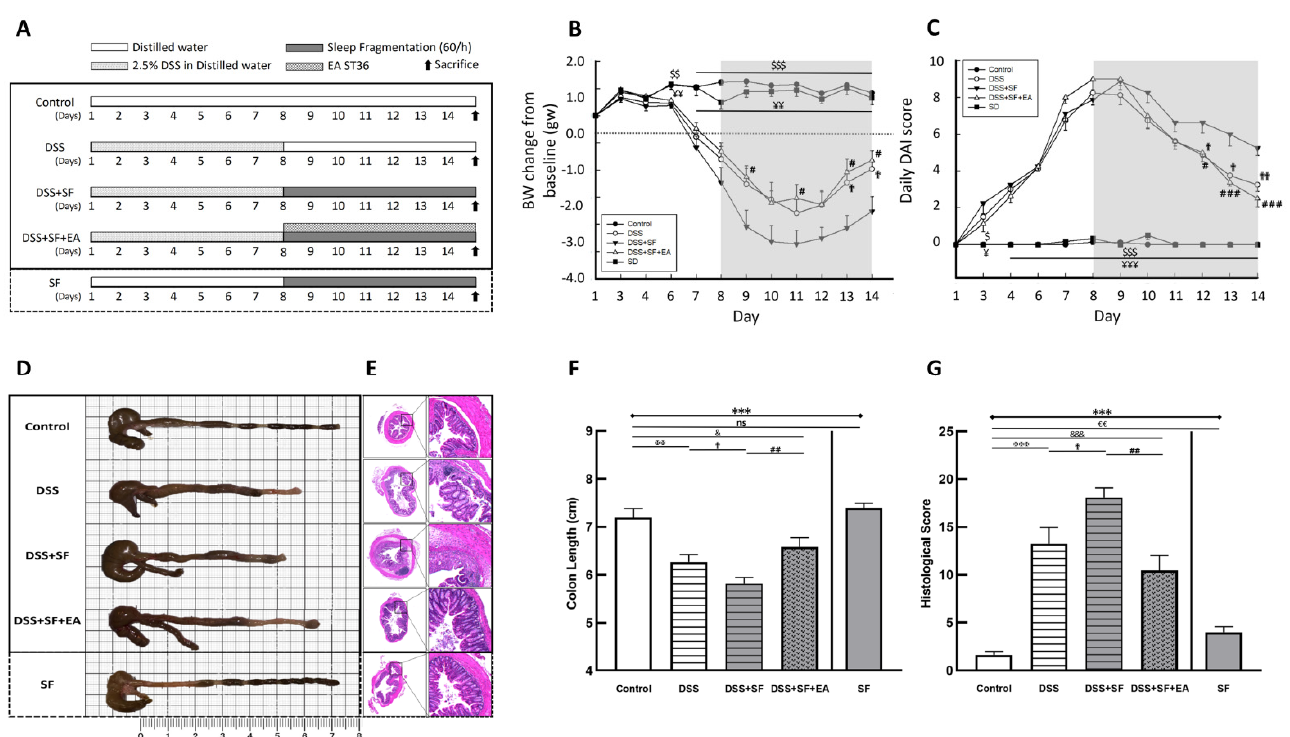
Figure 1. Electroacupuncture ameliorates dextran sulfate sodium (DSS)-induced colitis in sleep- fragmented C57BL/6 mice. ( A ) Experimental protocol of 2.5% DSS colitis, sleep fragmentation (SF) and electroacupuncture (EA) ST36 treatment course; ( B ) mice body weight loss after management of DSS or sleep fragmentation in five groups (statistics of differences between each group and DSS + SF group by Mann–Whitney U test); ( C ) daily DAI score in five groups (statistics of differences between each group and DSS + SF group by Mann–Whitney U test); ( D ) intestine photograph of colorectum length in each group; ( E ) representative H&E-stained colorectum sections (left: 40×, right: 200× magnification) in each group; ( F ) statistics of colon length in five groups by Kruskal–Wallis test; differences between each group by Mann–Whitney U test; ( G ) statistics of histological score in five groups by Kruskal–Wallis test; differences between each group by Mann–Whitney U test. * Stands for a result of five groups comparison (represented by bold line segments with endpoints). ✠ , $, ✟ , #, ¥, & and € represent the results of control group versus DSS group, control group versus DSS + SF group, DSS group versus DSS + SF group, DSS + SF group versus DSS + SF + EA group, DSS + SF group versus SF group, control group versus DSS + SF + EA group, and control group versus SF group, respectively (represented as a thin line without endpoints). $, ✟ , #, ¥, &, €, p < 0.05; ✠✠ , $$, ✟✟ , ##, ¥¥, €€, p < 0.01; ***, ✠✠✠ , $$$, ¥¥¥, &&&, p < 0.001; ns, no significance. Data were presented as mean ± SEM of six mice in each group. DSS, dextran sodium sulfate; SF, sleep fragmentation; EA, electroacupuncture.